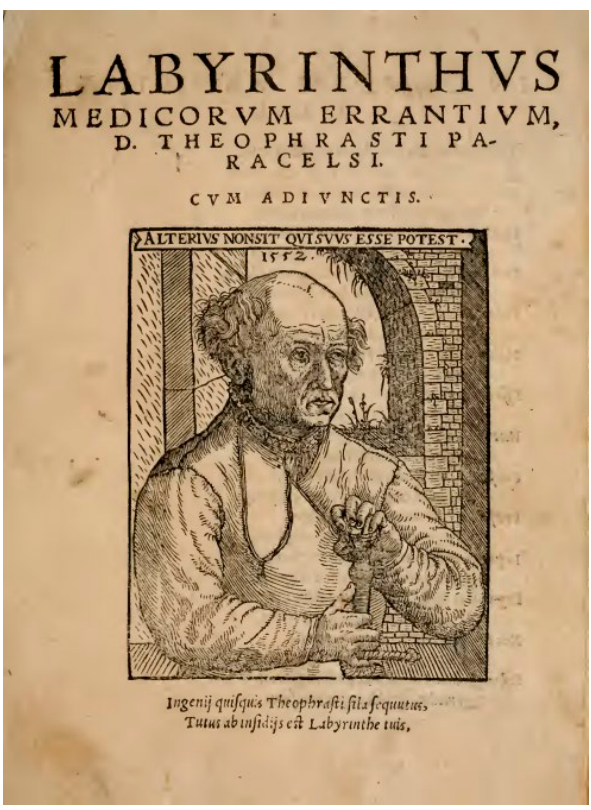
Figure 4. Label of Laudanum bottle prepared by Chas. Hooper & Sons, Chemists and Druggists,